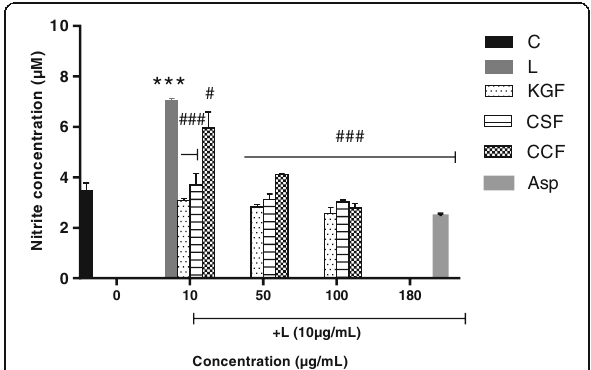
Fig. 3 Effects of polysaccharides fractions of Khaya grandifoliola stem bark (KGF), Cryptolepis sanguinolenta (CSF) and Cymbopogon citratus (CCF) leaves and Aspirin (Asp) on the secretion of NO by LPS-stimulated RAW 264.7 macrophages cells. C-Non-treated cells; L-LPS (10 μ g/mL) treated cells, Asp-Aspirin 1 μ M (180 μ g/mL) treated cells, Data expressed as mean±SEM ( n =3). *, **, *** denote statistical significance at p <0.05, p <0.01 & p < 0.001 in comparison to the control group. #, ##, ### denote statistical significance at p <0.05, p <0.01 & p <0.001 in comparison to the LPS treated group (Dunnet multiple comparison, graph Pad Prism 6.0)